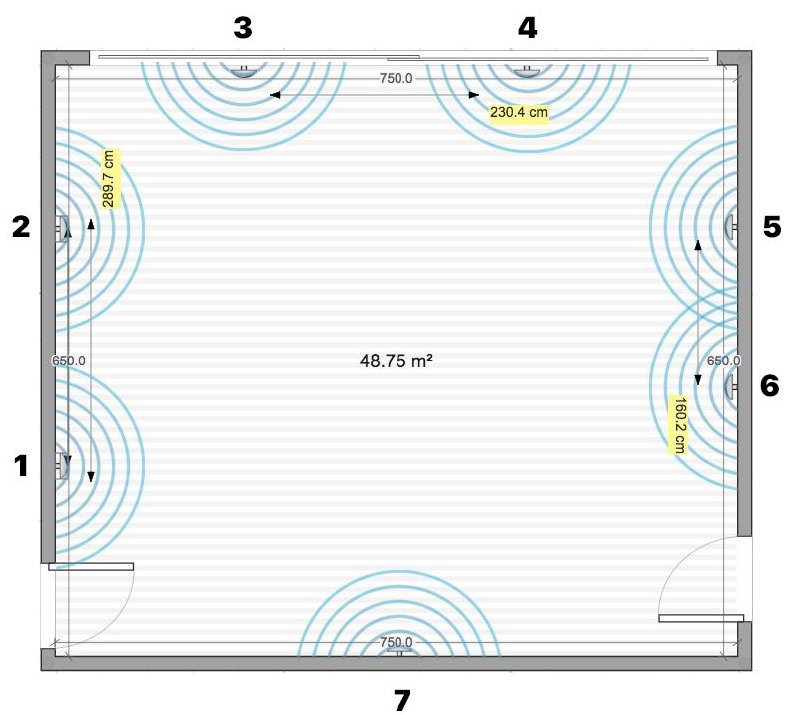
Figure 4. Testing environment with low or no obstacle severity. Figure 6. Testing environment with low or no obstacle severity. Sensors 2020 , 20 , x FOR PEER REVIEW